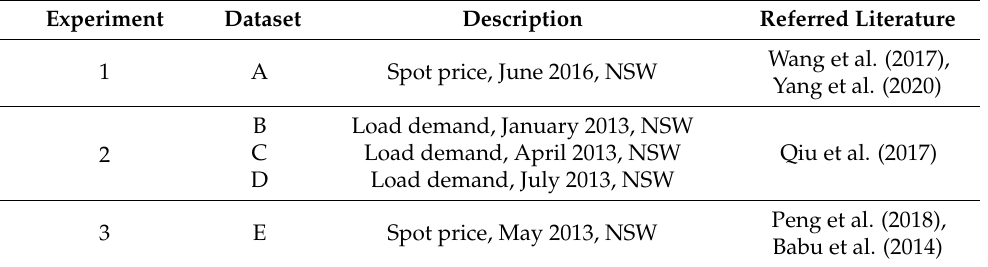
Table 1. Experiment setup.